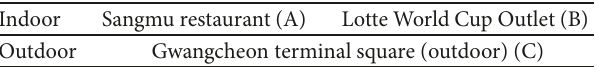
Figure 1: Measurement environment. Table 2: Measurements